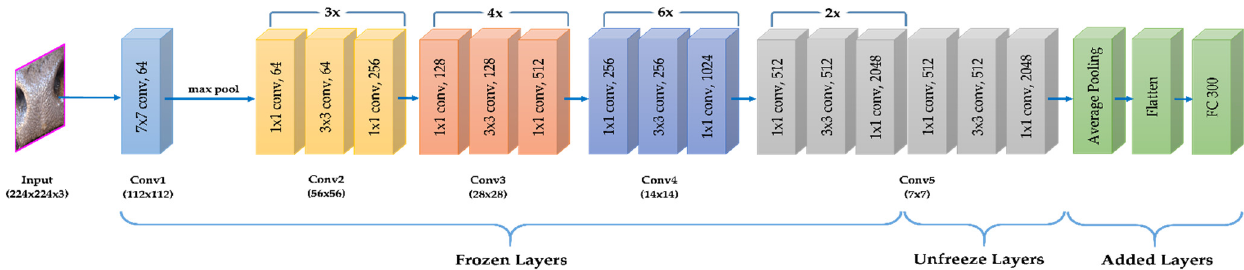
Figure 4. The proposed ResNet-50 muzzle pattern identifier model architecture.